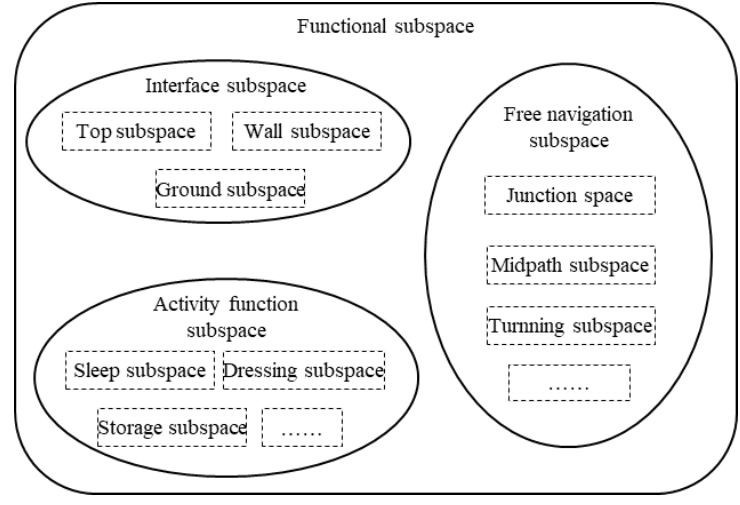
Figure 8. Classification of indoor functional subspaces.